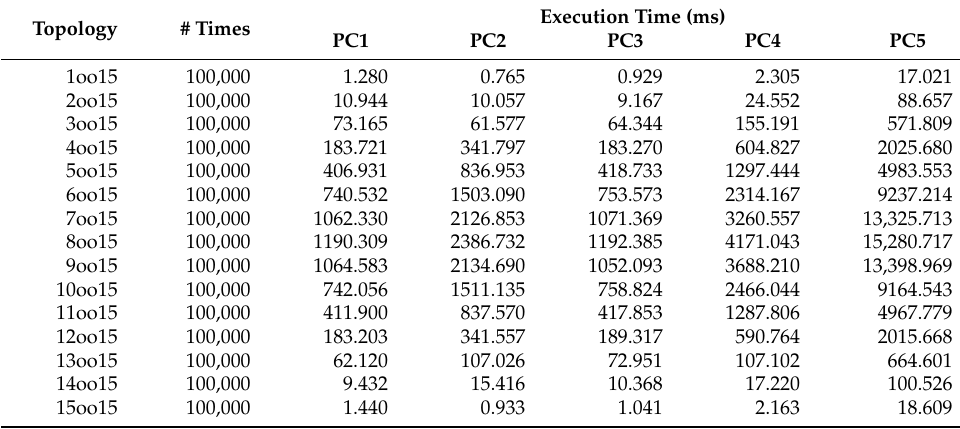
Table 11. Performance evaluation of K oo15 generic